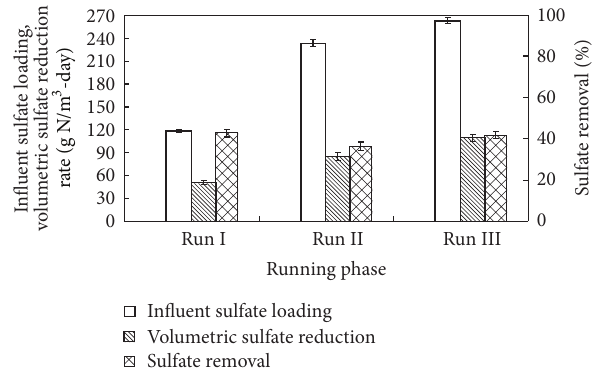
Figure 4: Influent sulfate loading, volumetric sulfate reduction rate, and sulfate removal in the experiment. Error bars represent the standarddeviationbetweencontinuoussamplesduringonerunning